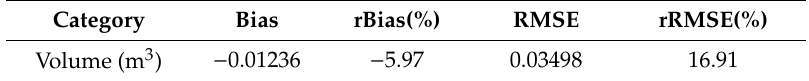
Table 1. Accuracy comparison of tree volume extracted by this model and TreeQSM.